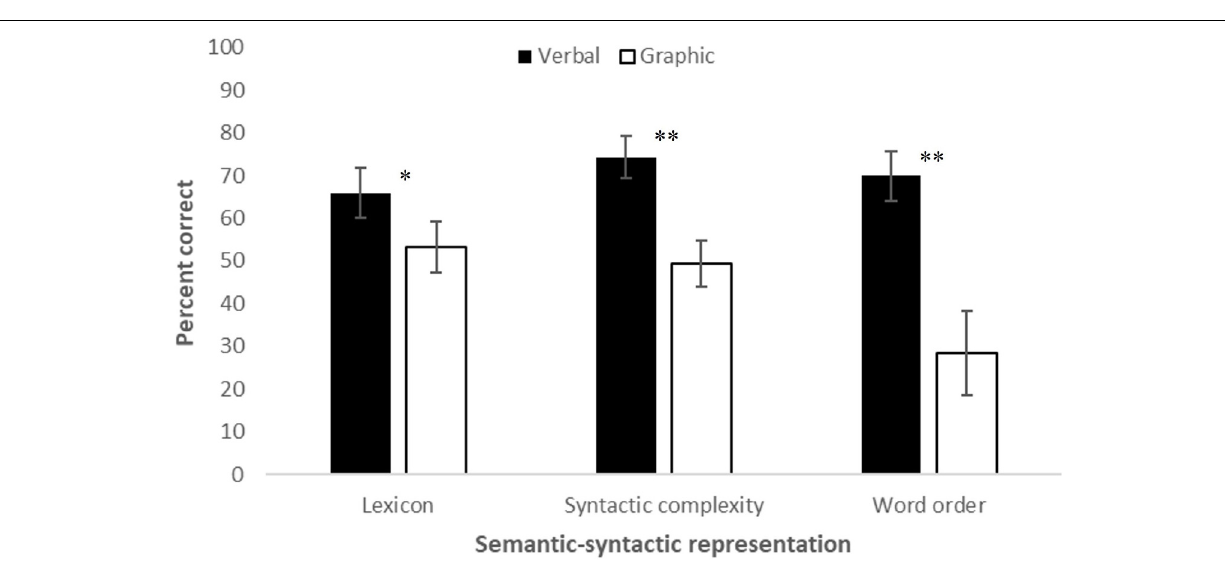
FIGURE 2 | Verbal and graphic scores for the different sematic-syntactic representation. ∗ p < 0.05; ∗∗ p <